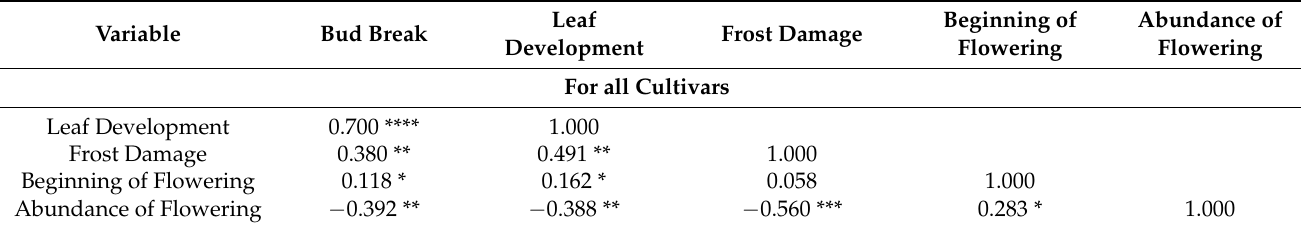
Table 7. Correlation matrices between frost damage, early phenology stages, beginning of flowering, and its abundance in rambler roses for all cultivars taken together.